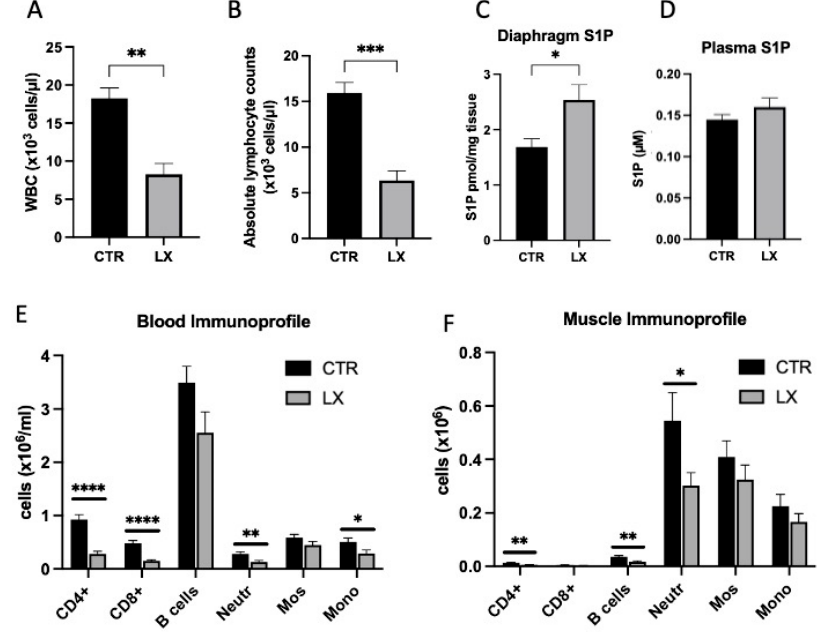
Figure 3. LX2931 perinatal treatment raises skeletal muscle S1P levels and induces lymphopenia in